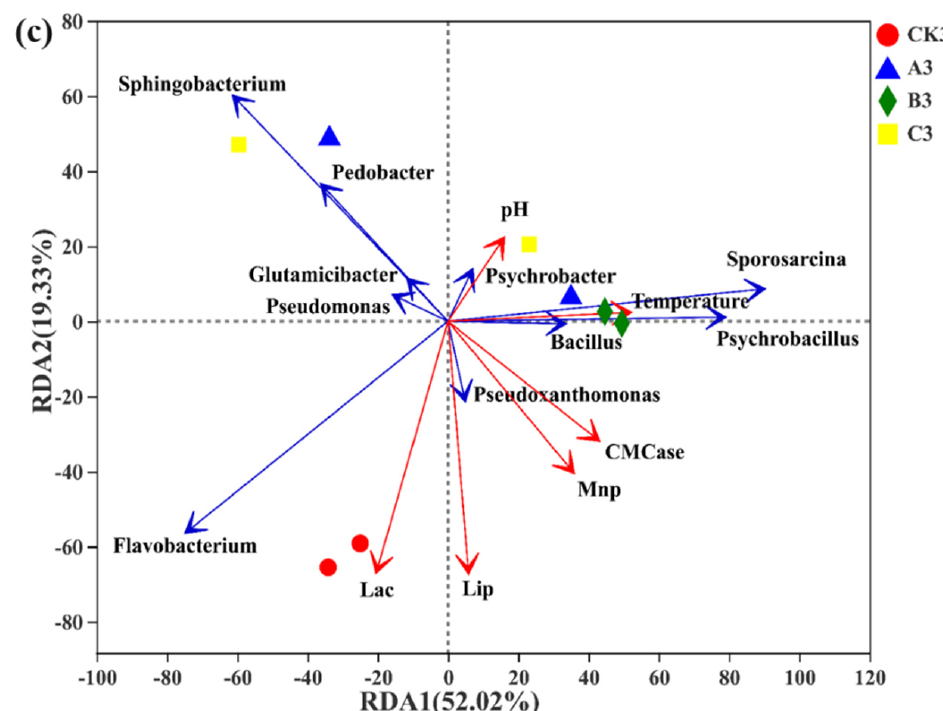
Figure 6. RDA of environmental factors and the most abundant bacterial genera in compost groups inoculated with different microorganisms. Mesophilic phase ( a ); thermophilic phase ( b ); cooling phase ( c ).